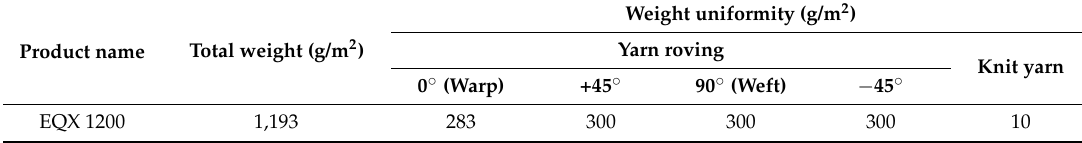
Table 2. Mechanical properties of GFRP laminates (supplied by Owenscorning, Toledo, OH, USA).